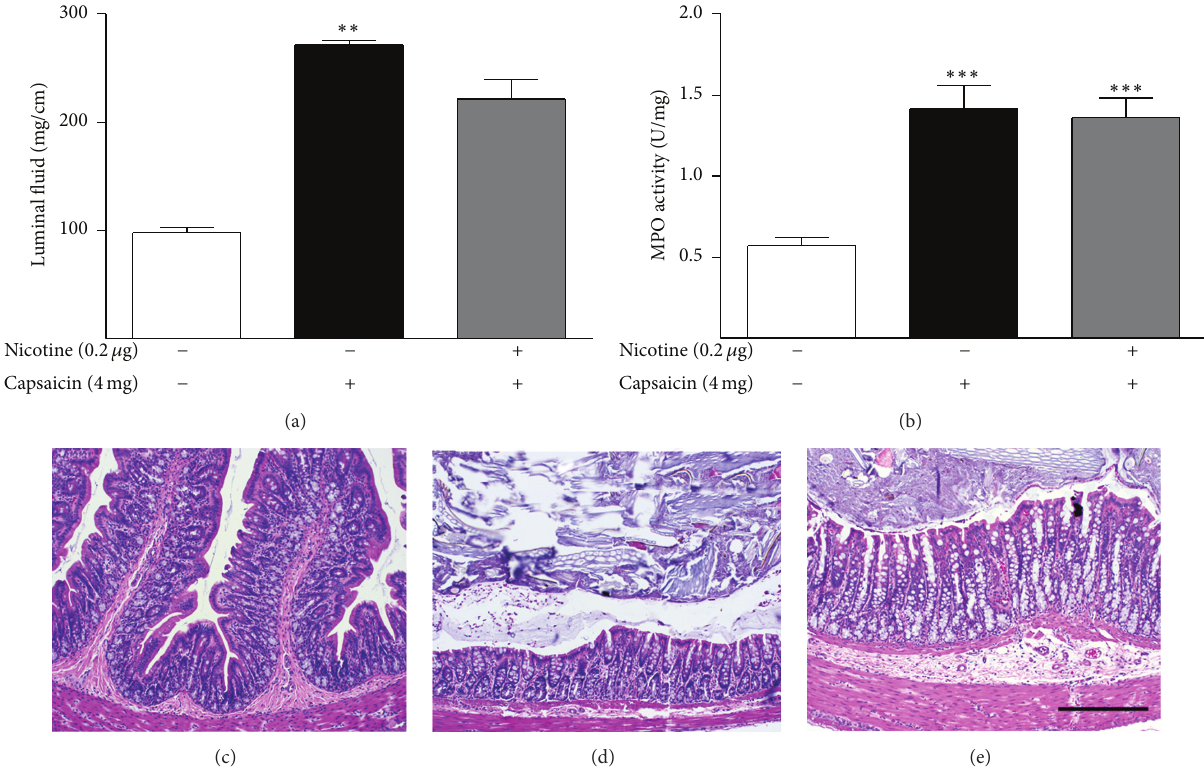
Figure 5: Effects of pretreatment with nicotine (0.2 𝜇 g) on capsaicin-induced (4 mg) luminal fluid accumulation (a) and MPO content (b) in the colon. Capsaicin is a direct TRPV1 agonist. Nicotine pretreatment had no effect on capsaicin-stimulated colitis in this model, unlike the effect of nicotine on toxin A-stimulated colitis as shown. ∗∗ 𝑃 < 0.01 versus control; ∗∗∗ 𝑃 < 0.001 versus control; 𝑁 = 5 . (c) Control section illustrating the normal histology of the rat colon; (d) capsaicin (4mg) causes extensive inflammatory damage to the colon including loss of mucosal folding, crypt distortion, surface ulceration, and influx of neutrophils; (e) capsaicin (4mg) after pretreatment with 0.2 𝜇 g nicotine. This dose of nicotine was maximally effective against toxin A in the colon but did not protect against capsaicin. Line bar = 100 𝜇 m.